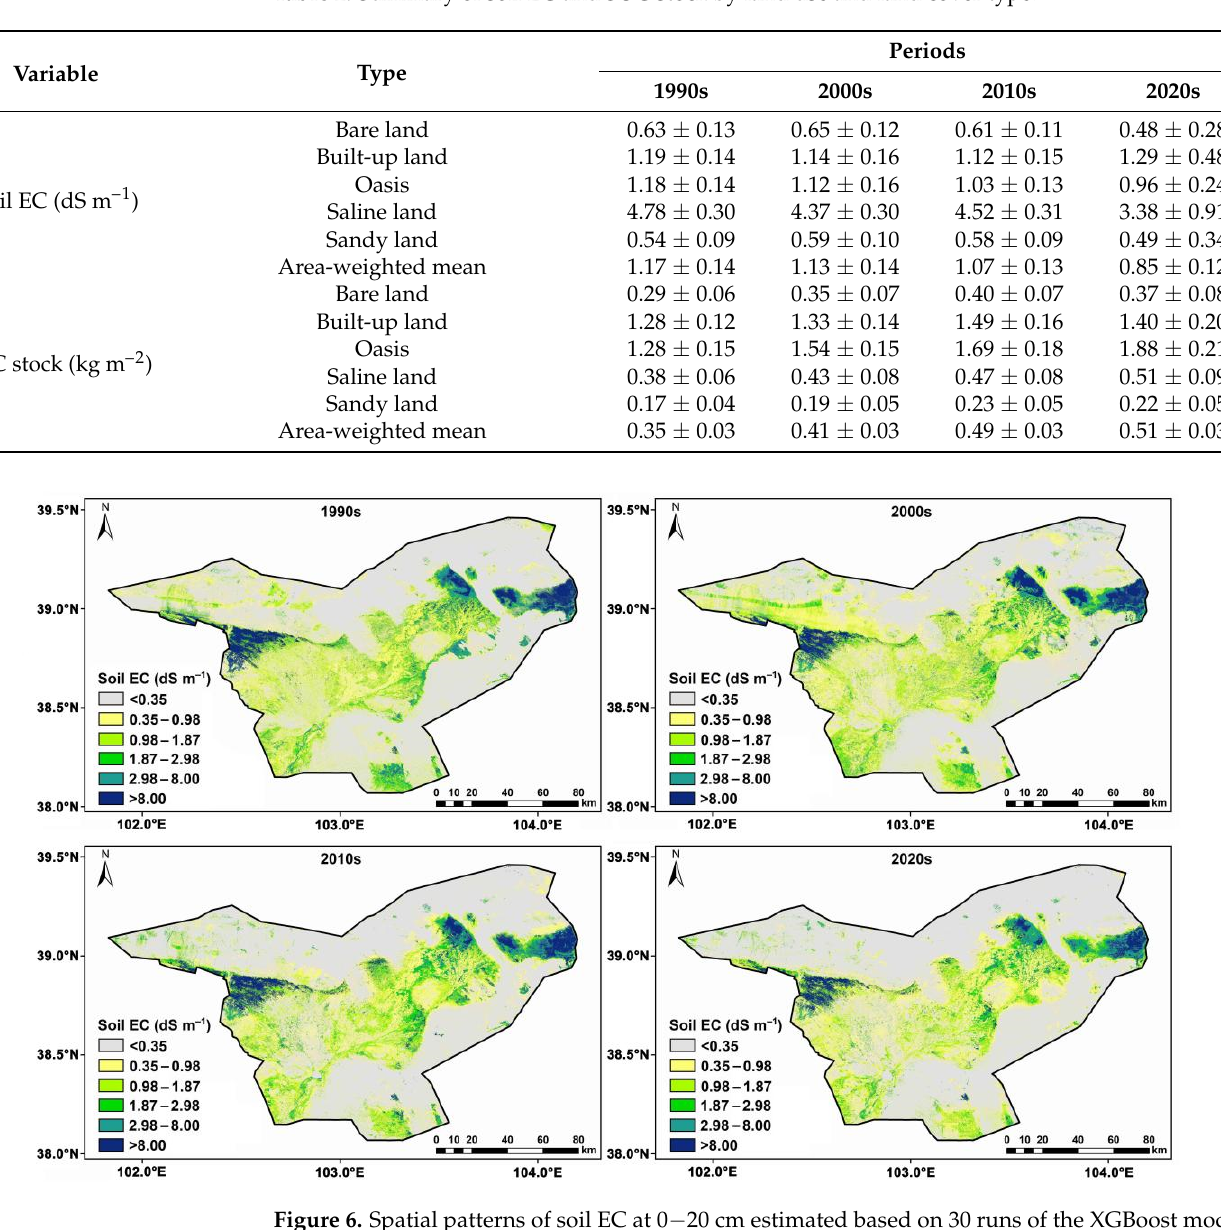
Table 2. Summary of soil EC and SOC stock by land use and land cover type.